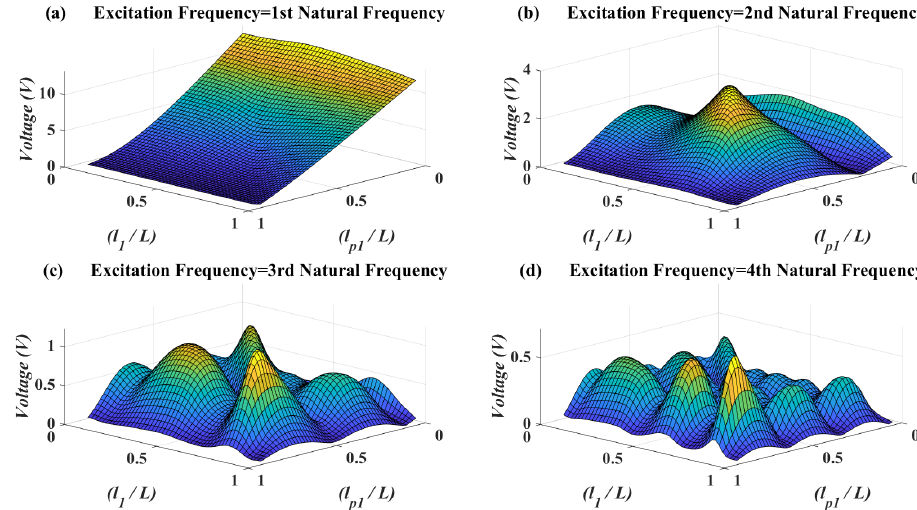
Figure 5. Piezoelectric voltage amplitude for different attachment location versus piezoelectric patch location— M = µ L , J = 0, x F = L